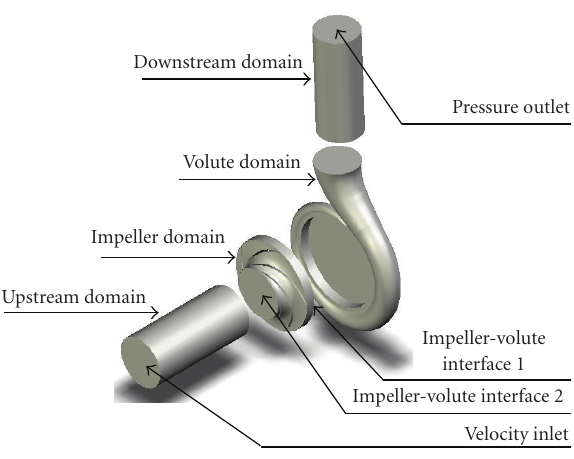
Figure 4: Flow and boundary condition domains.